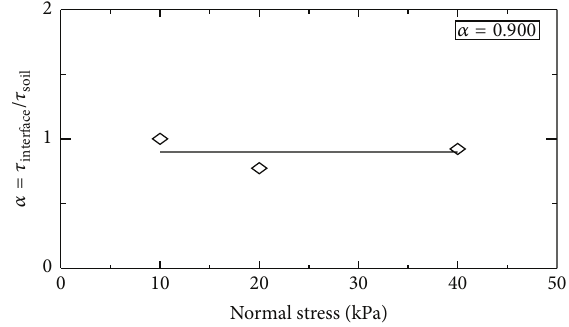
Figure 8: Relationship between coefficient of soil-reinforcement friction 𝛼 and normal